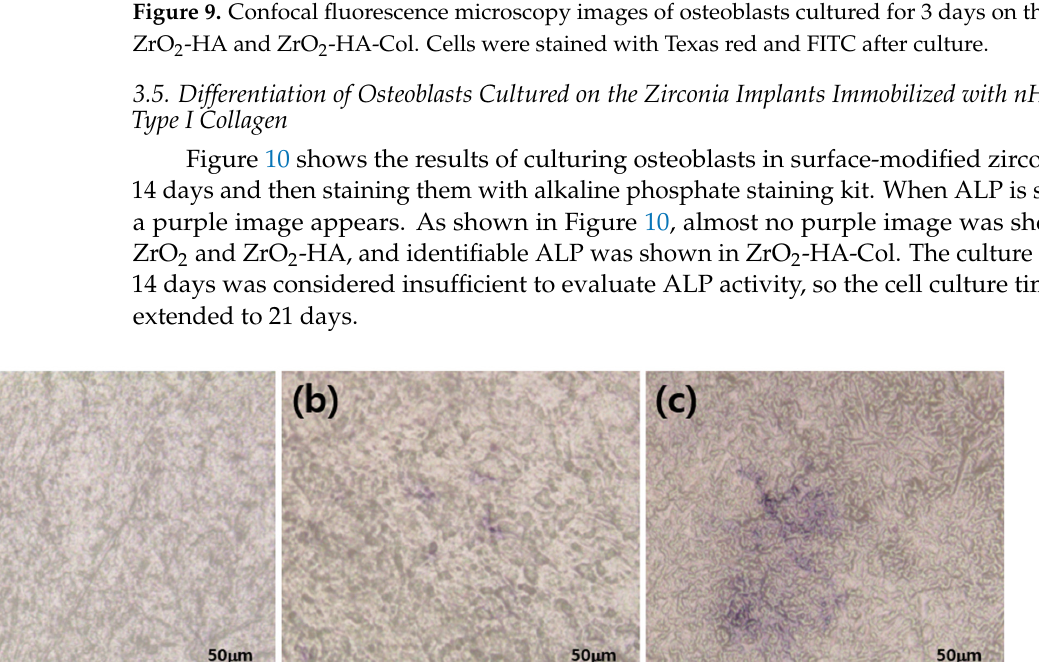
Figure 11. Alkaline phosphatase activity of MC3T3-E1 cells cultured on ZrO 2 ( a ), ZrO 2 -HA ( b ) and ZrO 2 -HA-Col ( c ). After culturing the cells for 21 days, the cells were stained with Fast Blue RR salt and naphthol AS MX phosphate alkaline solution, and a purple image showing ALP activity was observed under an optical microscope. Alizarin red staining indicates the process of transformation of undifferentiated MC3T3-E1 cells to osteoblasts and their subsequent mineralization leading to bone for- mation. In vitro Alizarin red staining enables us to visualize the process of osteogenesis by producing a red color on calcium deposition. The intensity of alizarin red staining for MC3T3-E1 cells (red spots) inoculated on clean ZrO 2 (Figure 12a), ZrO 2 -HA (Figure 12b) and ZrO 2 -HA-Col (Figure 12c) was compared. As a result, the osteogenic levels of cells cultured on ZrO 2 -HA (Figure 12b) and ZrO 2 -HA-Col (Figure 12c) were significantly higher than on ZrO 2 .